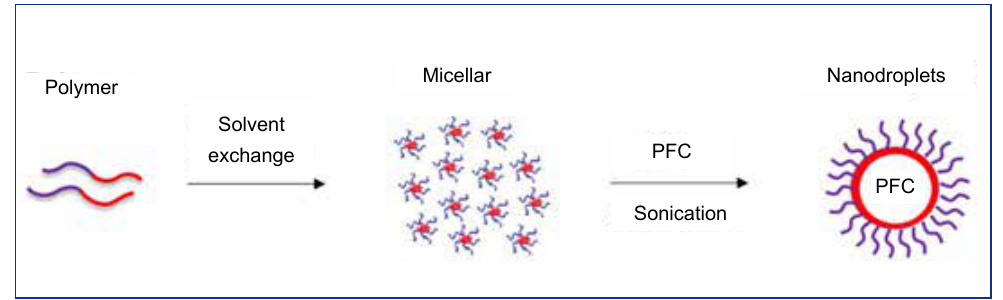
Figure 3 Schematic of preparation method for block copolymer stabilized